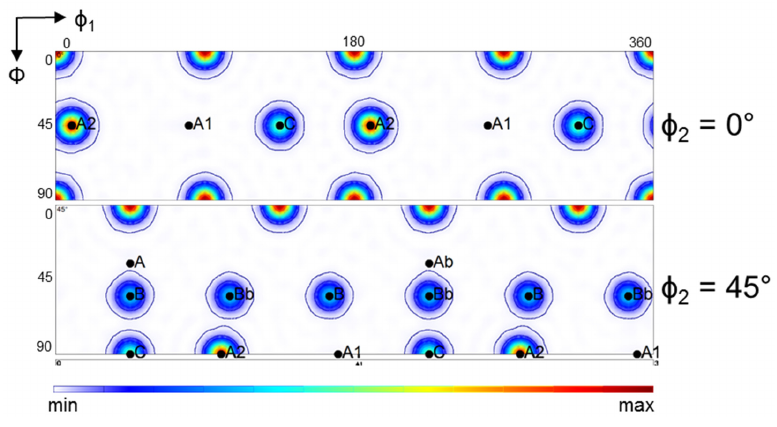
Figure 13. The relative twinning capacity of the ideal ECAP texture components and of the Cube orientation. The Cube orientation is the most prone to twin, followed by the A2, C and the B/Bb components. A1 and A/Ab do not twin.